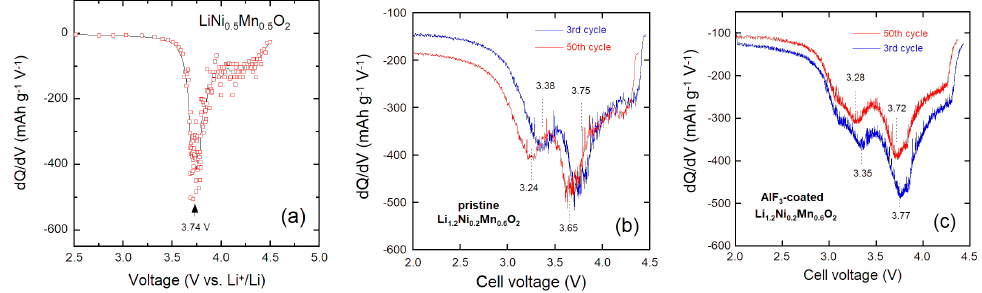
Figure 10. Incremental capacity (-d Q / d V vs. V ) plots for ( a ) LiNi 0.5 Mn 0.5 O 2 , ( b ) pristine LLNMO, and ( c ) AlF 3 -coated LLNMO.